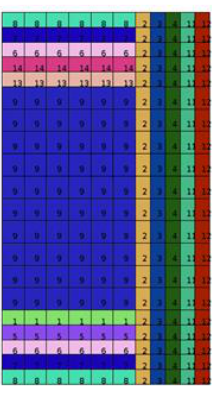
Figure 2. Numerical testing